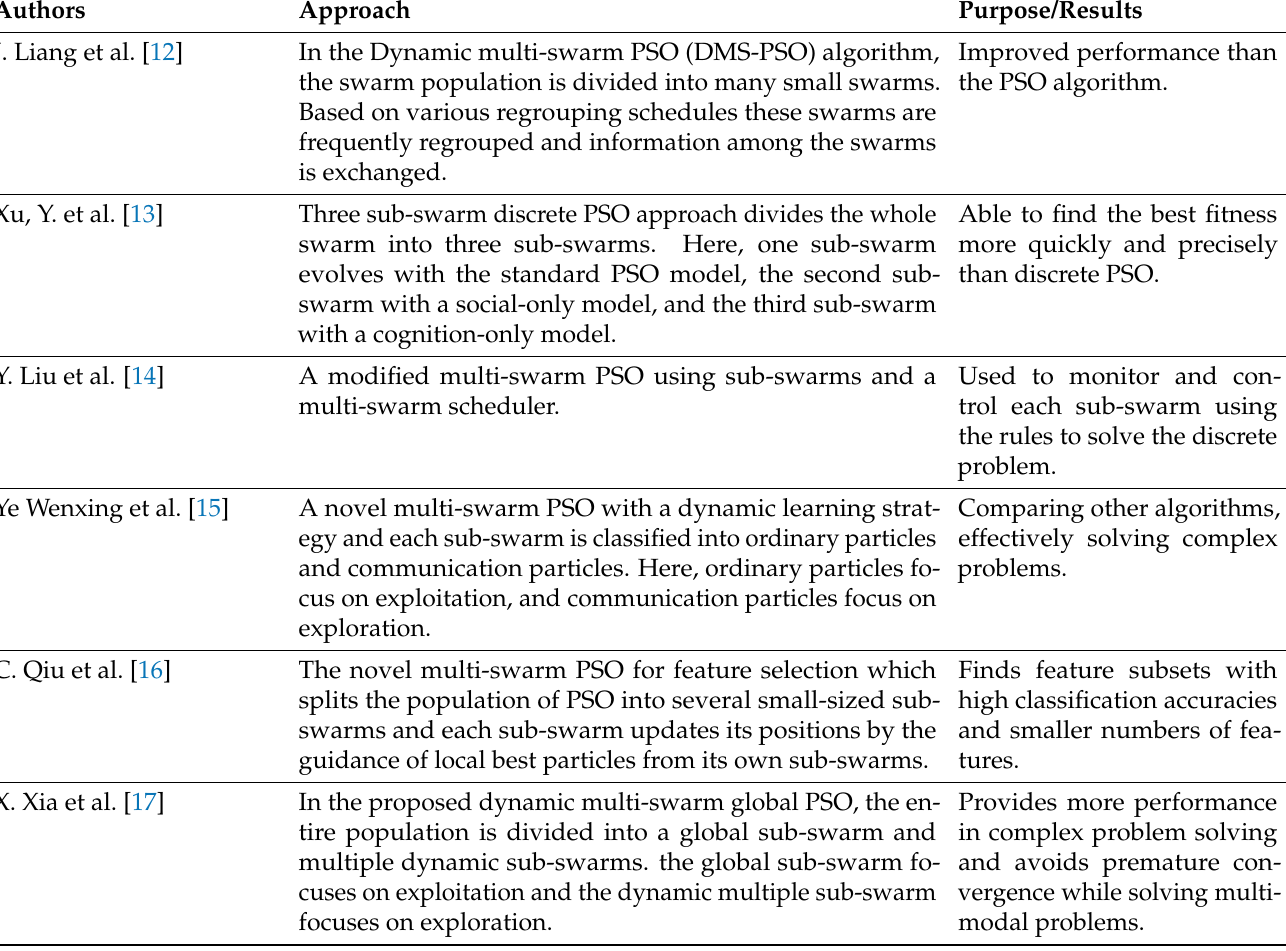
Table 1. Related research